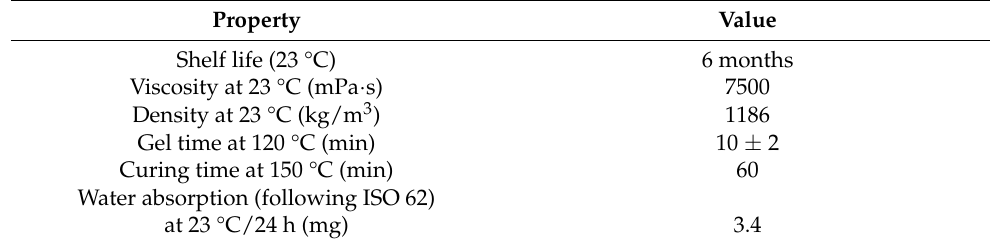
Table 1. The basic properties of used PEI resin.